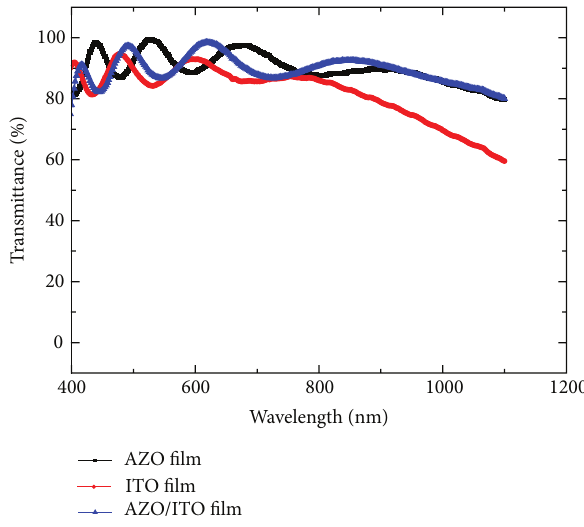
Figure 5: Optical transmittance spectra of AZO, ITO, and AZO/ITO films [12].